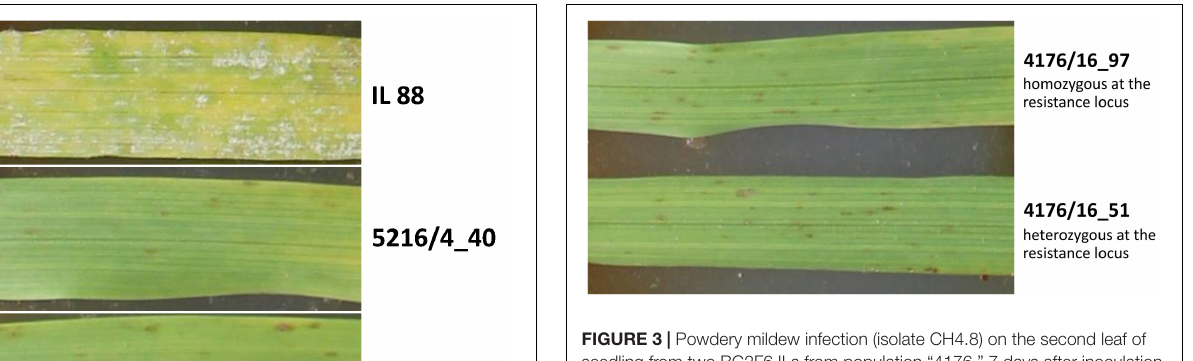
FIGURE 3 | Powdery mildew infection (isolate CH4.8) on the second leaf of seedling from two BC2F6 ILs from population “4176,” 7 days after inoculation. 4176/16_97 is homozygous at the resistance locus whereas 4176/16_51 is heterozygous. Their resistance phenotype is identical and present necrotic lesions characteristic of HR.